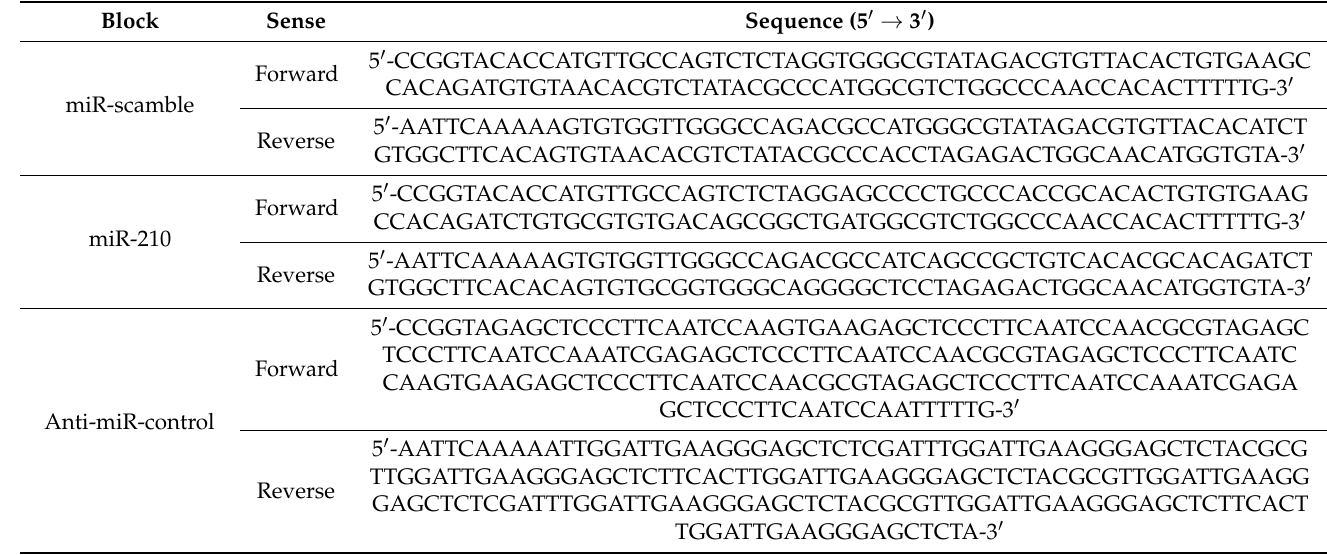
Table 1. Sequences of DNA blocks used for CRISPR/Cas9